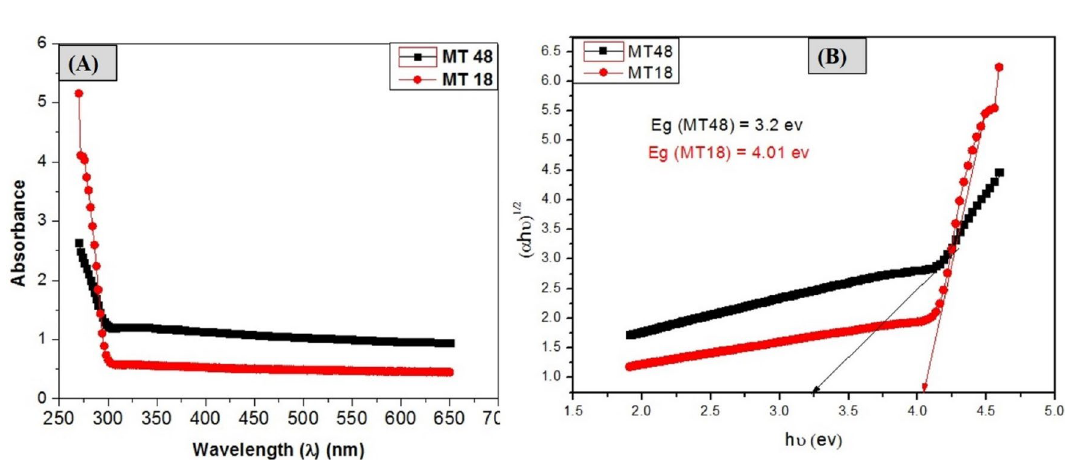
Figure 5. Optical behavior of MT18, MT48 ( A ) UV–Vis spectrum, ( B ) optical band gap